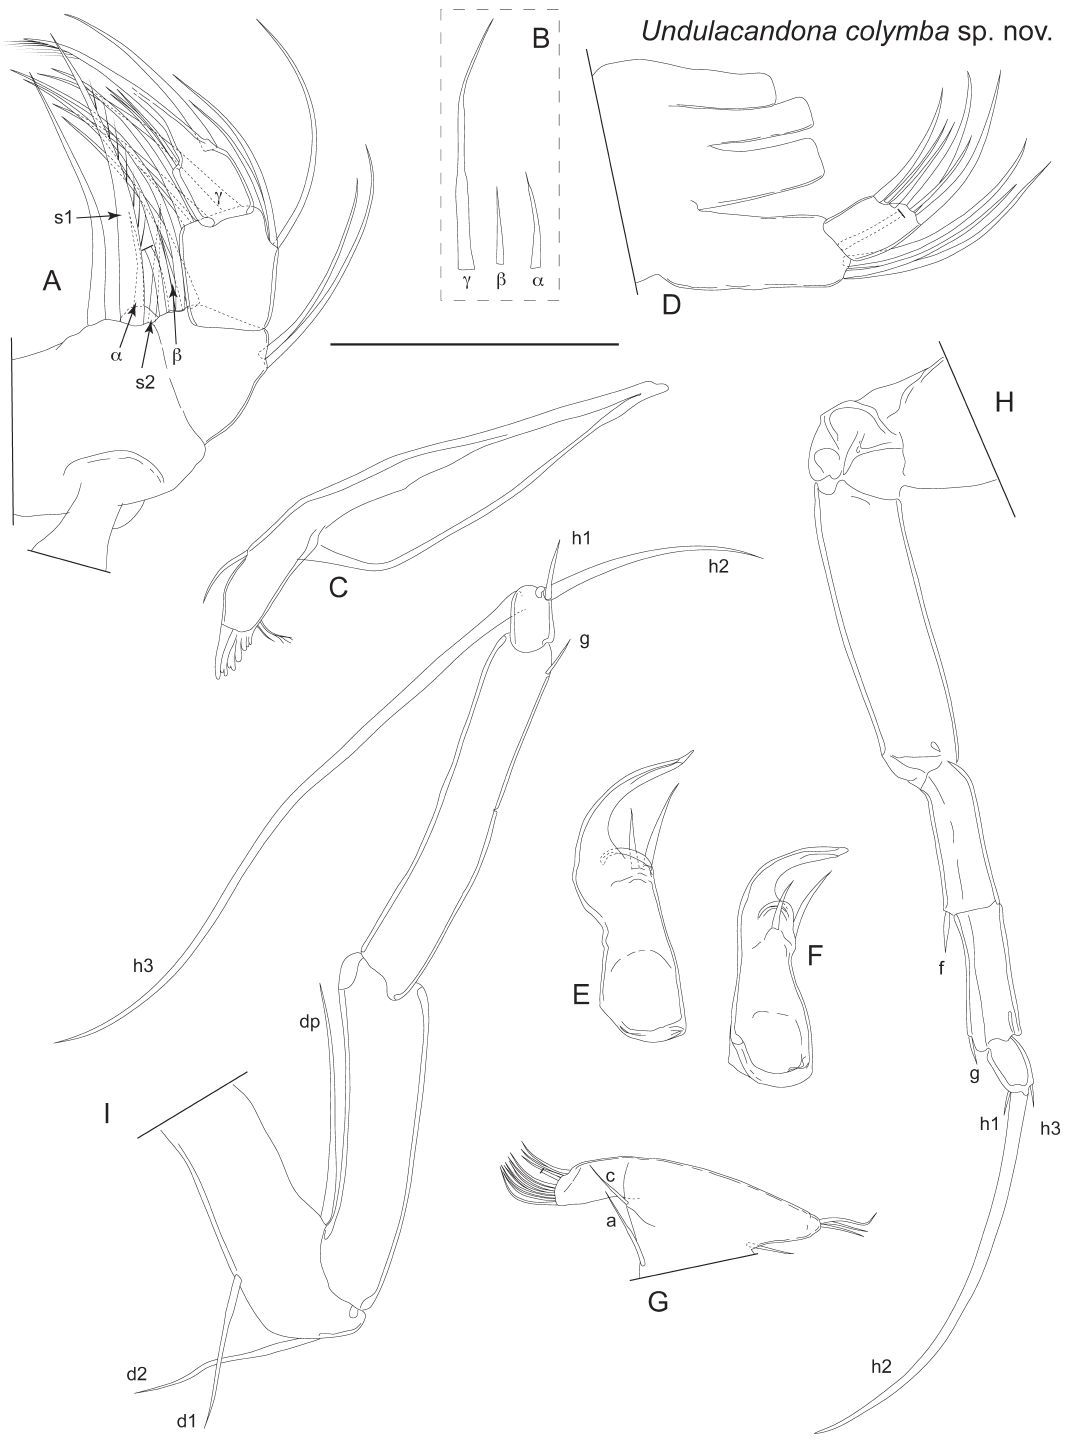
Fig. 16. Undulacandona colymba sp. nov. A . Female mandibular palp (LBM 1430006282). B . Alpha, beta and gamma setae of mandibular palp (LBM 1430006282). C . Female mandibular coxa (LBM 1430006282). D . Female maxillula (setae on endites not drawn) (LBM 1430006280). E–F . Left and right male fifth limb palps (LBM 1430006279). G . Female fifth limb (LBM 1430006282). H . Male sixth limb (LBM 1430006281). I . Female seventh limb (LBM 1430006280). Scale bar: A–B, D = 61 µm; C, E–I = 117